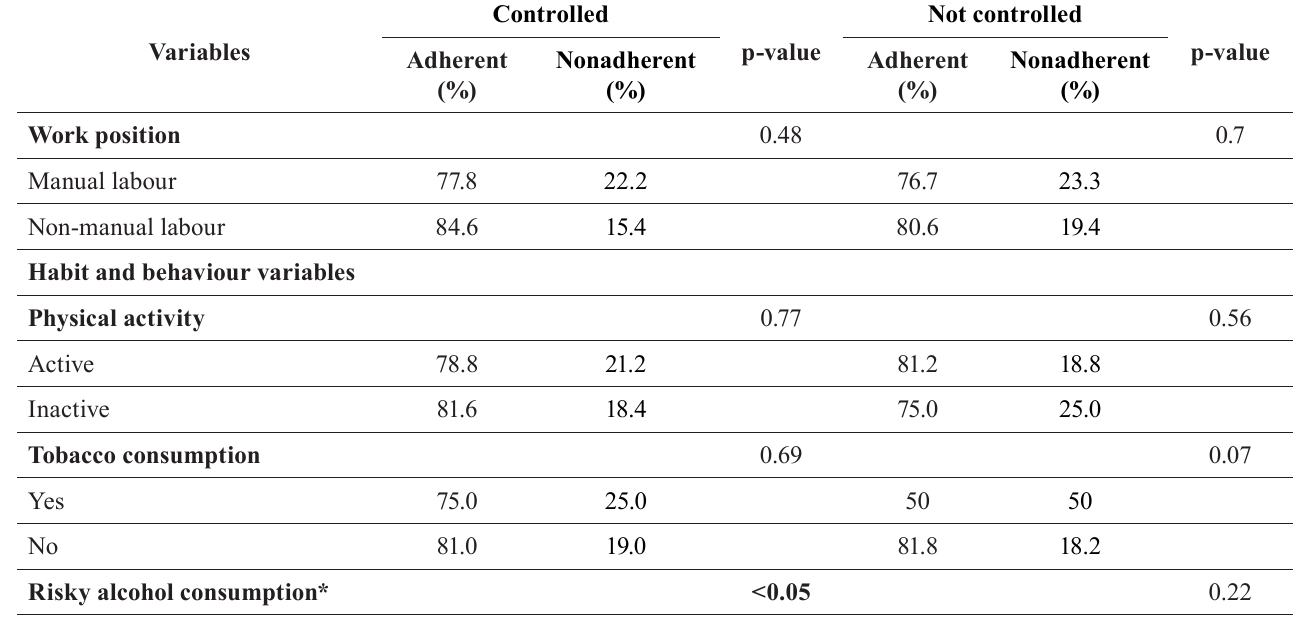
TABLE II - Prevalence of self-reported drug adherence in industry workers with controlled and uncontrolled hypertension and/ or diabetes mellitus, 2017 to 2018 Variables Work position 0.48 0.7